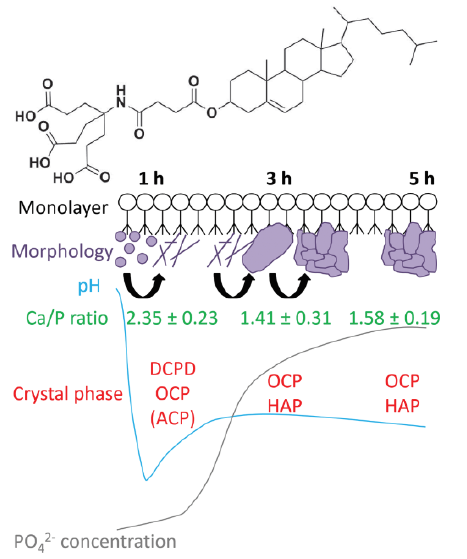
treated Ti surface Reproduced with permission from [166]. Copyright: The Author(s) .